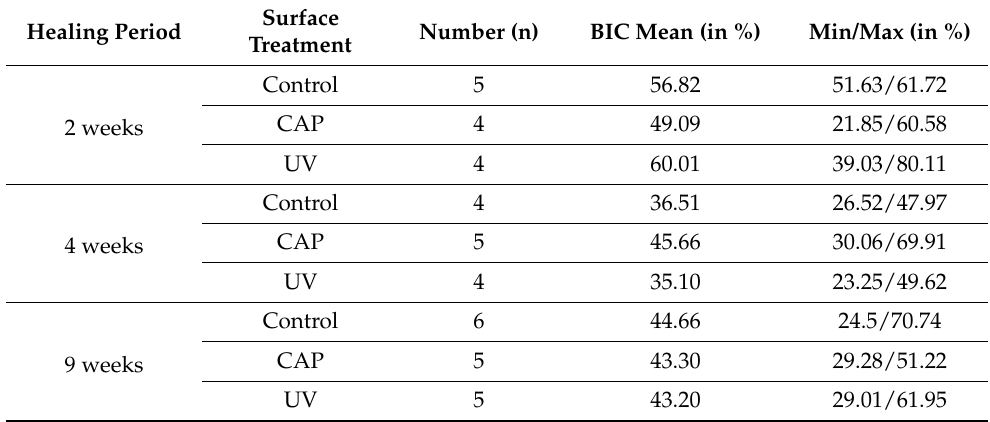
Figure 10. BIC values in percent ± standard deviation after 2, 4, and 9 weeks of healing. Table 1. BIC values after 2, 4, and 9 weeks of healing. Table 1. BIC values after 2, 4, and 9 weeks of healing.